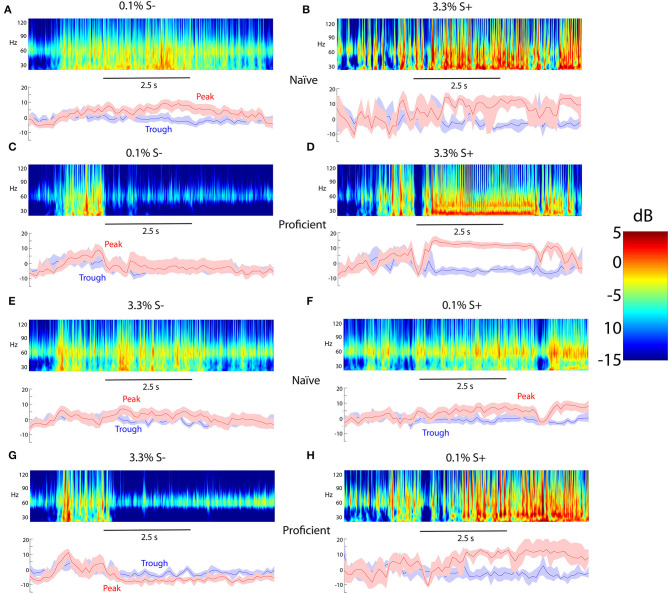
Examples of odorant-elicited changes in theta phase-referenced gamma power. (A–D) The rewarded stimulus (S+) is isoamyl acetate presented at a 3.3% cliq in MO while the unrewarded odorant (S-) is isoamyl acetate at cliq of 0.1% in MO. (A,B) Naïve mice. (C,D) Proficient mice. (E–H) The rewarded stimulus (S+) is acetophenone presented at a 0.1% cliq while the unrewarded odorant (S-) is acetophenone at a dilution of 3.3% cliq. (E,F) Naïve mice. (G,H) Proficient mice. For each condition the top panel shows a pseudocolor figure representing the average power computed using wavelet analysis and the bottom panel shows the average gamma power referenced at either the peak or trough of the theta LFP oscillation. The shadow shows the 95% CI. The number of trials used for each condition are as follows: (A) 24, (B) 4, (C) 12, (D) 8, (E) 20, (F) 19, (G) 8, (H) 4. The 2.5 s time scale bar denotes the time for odorant application.